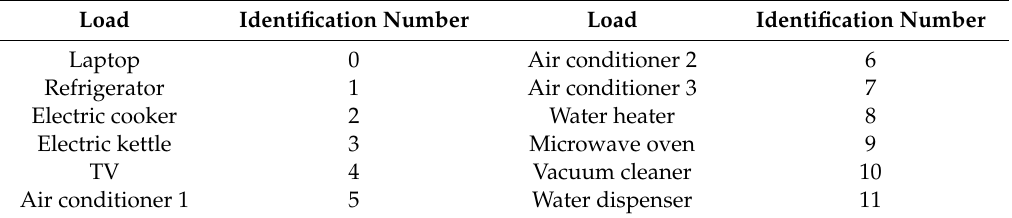
Table 3. Label number of load image